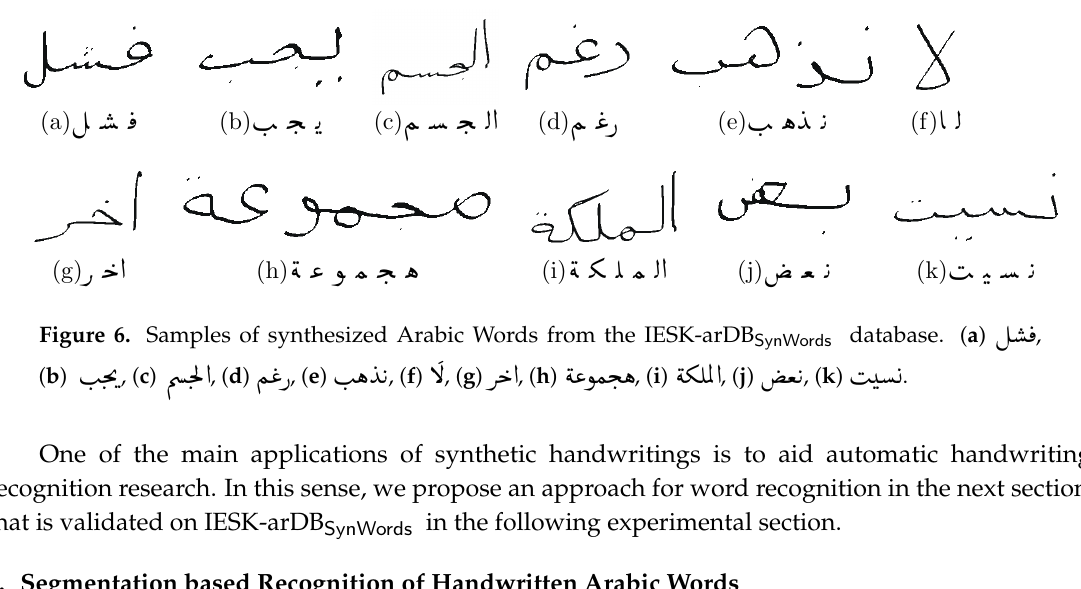
(cid:16) (cid:16) (cid:233)(cid:186)(cid:202)(cid:214)(cid:207)(cid:64) , ( j ) (cid:9) (cid:145)(cid:170)(cid:9) (cid:75) , ( k ) (cid:16) (cid:233)(cid:171)(cid:241)(cid:210)(cid:106)(cid:46) (cid:235) , ( i )